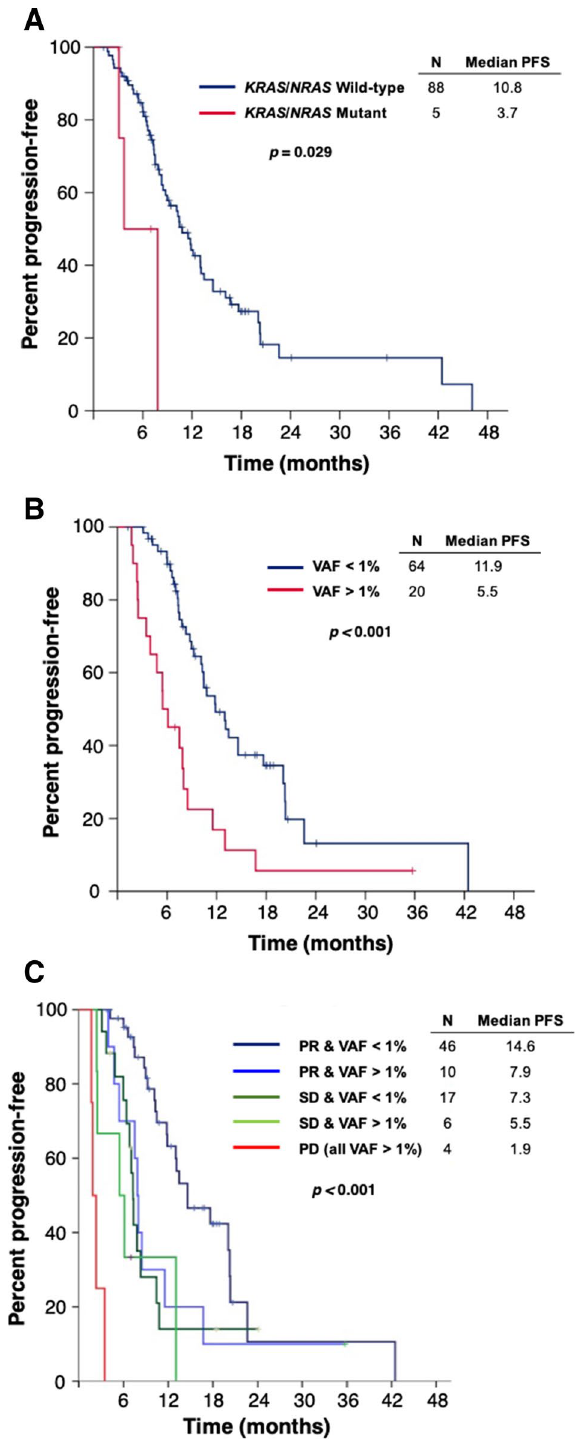
Figure 1. Treatment response related to baseline ctDNA mutations. ( A ) Kaplan–Meier curves of PFS according to baseline KRAS or NRAS hotspot mutations by ctDNA. ( B ) Kaplan–Meier curves of PFS according to average VAF changes after treatment. ( C ) Kaplan–Meier curves of PFS according to average VAF changes and RECIST 1.1 response groups at the time of first response evaluation (log-rank p -value for all